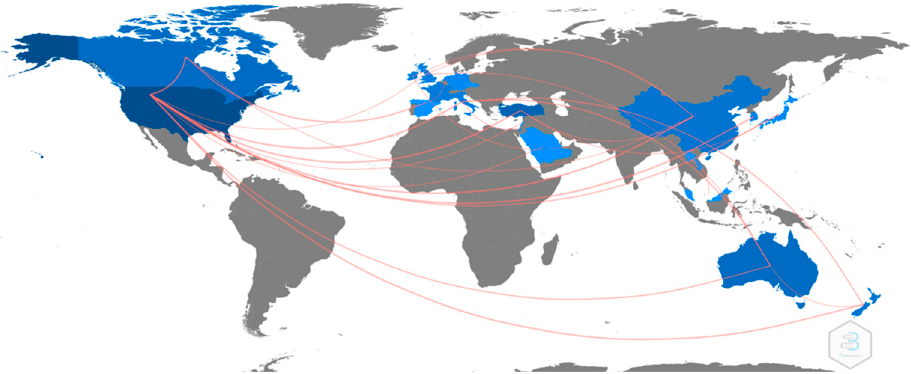
Figure 5. Country Collaboration Networks.